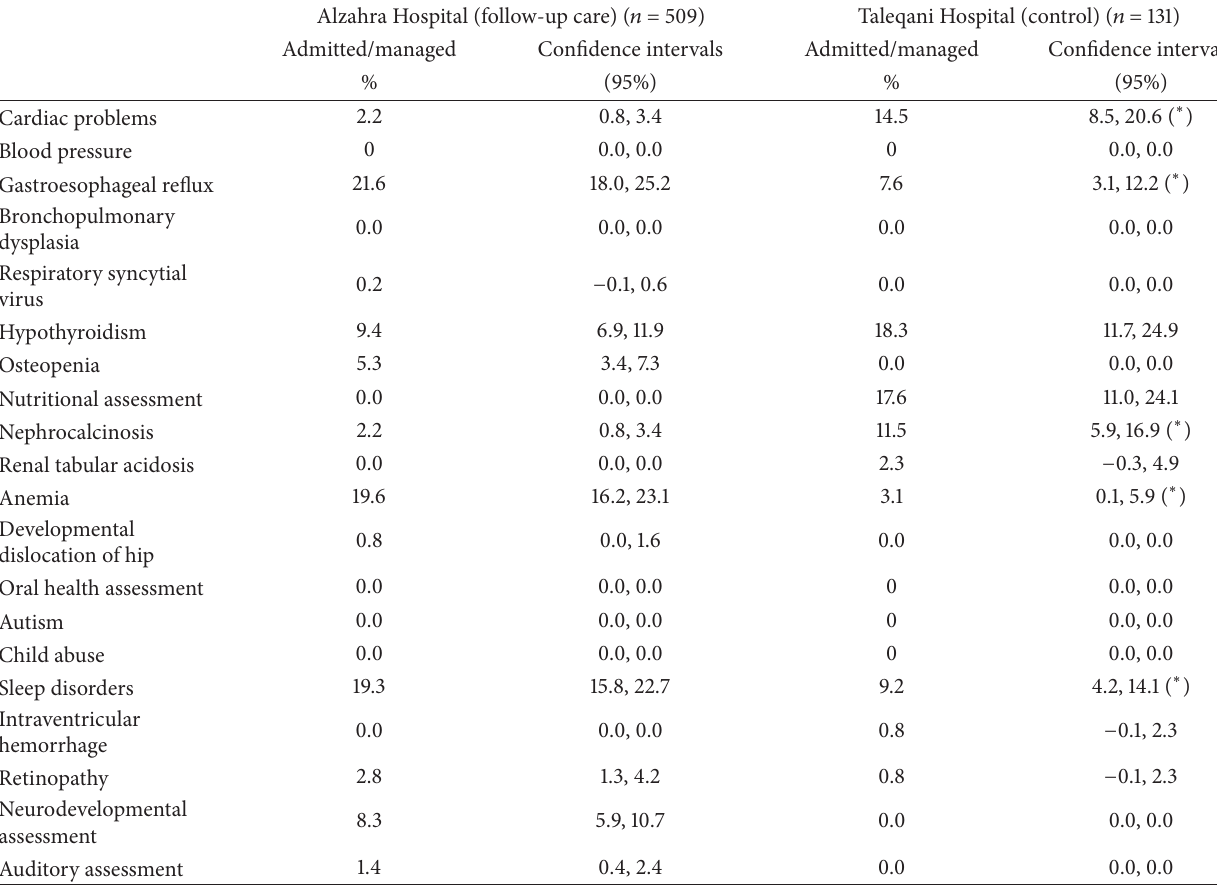
Table 2: Proportion of high risk infants clinically managed over the follow-up period. Alzahra Hospital (follow-up care) ( 𝑛 = 509) Taleqani Hospital (control) ( 𝑛 =